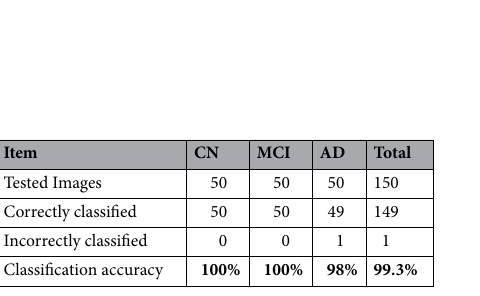
Table 5. The classification data for ADNI